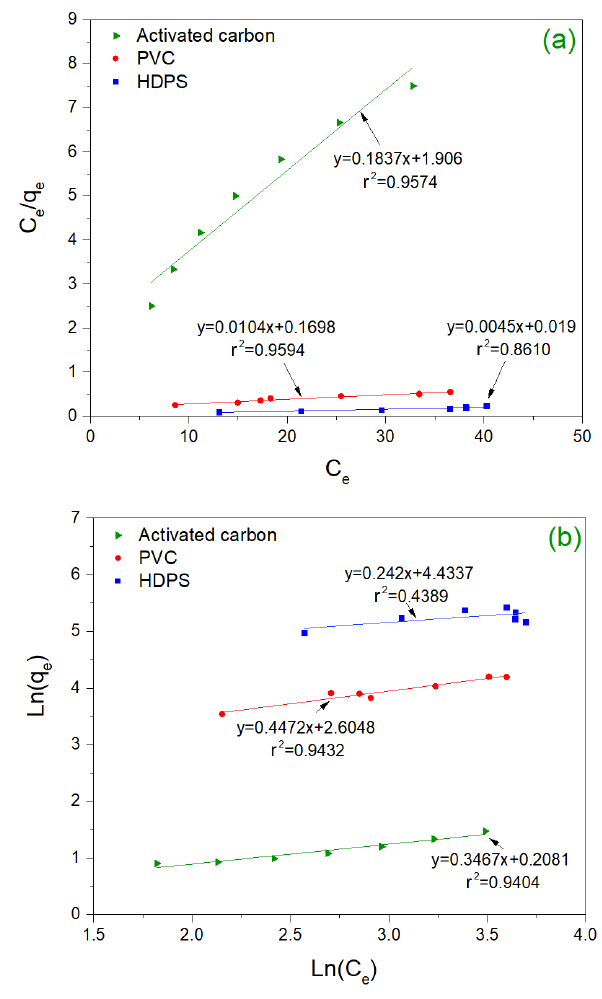
Figure 2. Results of Langmuir ( a ) and Freundlich ( b ) isotherms models for malathion adsorption on PVC and activated